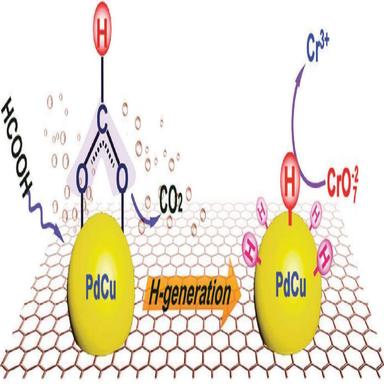
Schematic illustration of catalytic mechanism for the Cr(VI) reduction by FA over Pd6Cu4/NG catalyst).